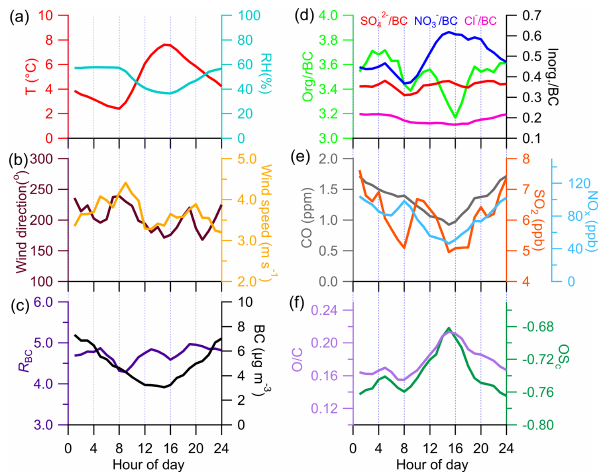
Figure 5. Diurnal cycles of (a) T and RH, (b) wind direction and wind speed, (c) mass ratio of coatings to BC ( R BC ) and BC, / BC, NO − / BC and Cl − / BC, (e) mass loadings (d) org / BC, SO 2 − 4 3 of gaseous species (CO, SO 2 , NO x ) and (f) O / C and oxidation state (OS c = 2 × O / C − H /